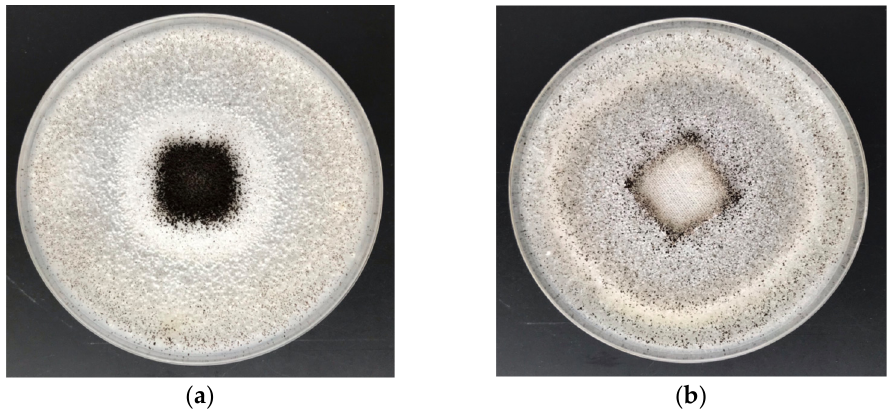
Figure 7. Antimicrobial activity tests against A. niger. Inhibition properties of fungal growth in Petri dishes: ( a ) COT; ( b ) COT–Zn-10 (1 s/2 s).